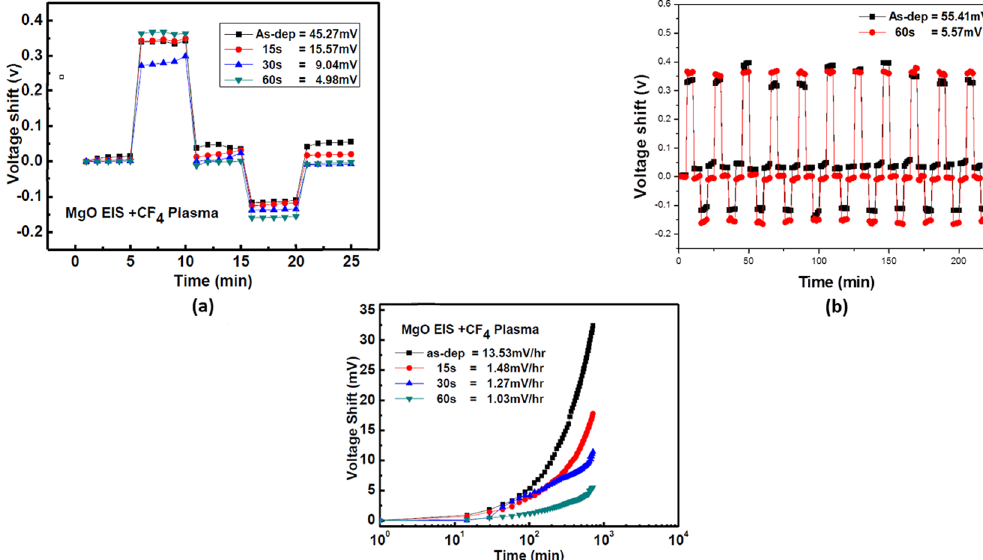
Figure 7. ( a ) The hysteresis of MgO sensing membranes with CF 4 plasma treatment in various conditions during the pH loop of 7 → 4 → 7 → 10 → 7 over a period of 25 minutes. ( b ) The hysteresis of MgO sensing membranes without CF 4 plasma treatment and with 60 sec CF 4 plasma treatment after the pH loop of 11 cycles. ( c ) The drift voltage of MgO sensing membrane with CF 4 plasma treatment in various conditions, then dipped in pH 7 buffer solution for 12 hours.